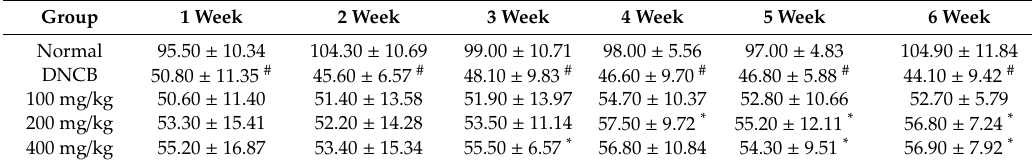
Table 3. The e ff ect of CQ on the skin hydration in DNCB-induced BALB / c mice.